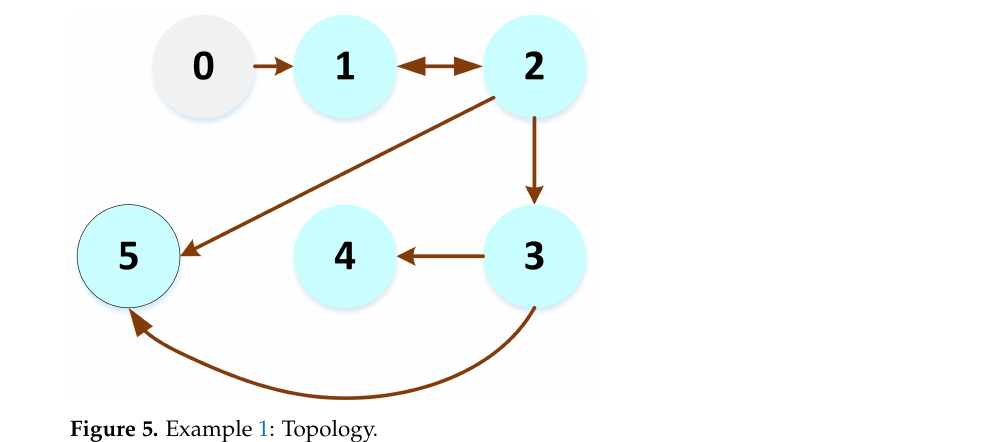
Figure 5. Example 1: Topology.